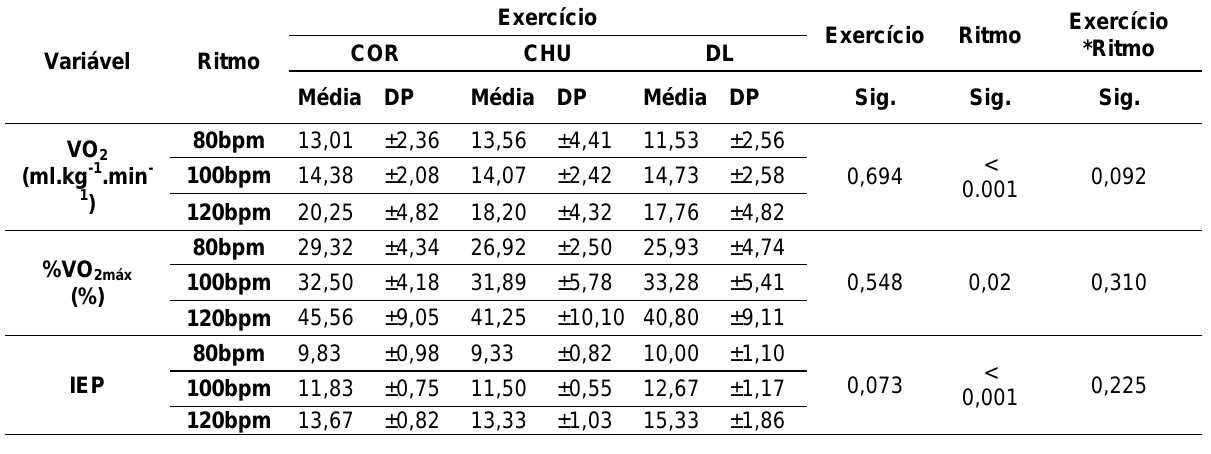
Tabela 3. Média, desvio padrão (DP) e níveis de significância dos efeitos principais exercício e ritmo de execução e interação exercício*ritmo para as variáveis consumo de oxigênio (VO (COR), chute frontal até 45° (CHU) e deslize lateral (DL) executados nas diferentes